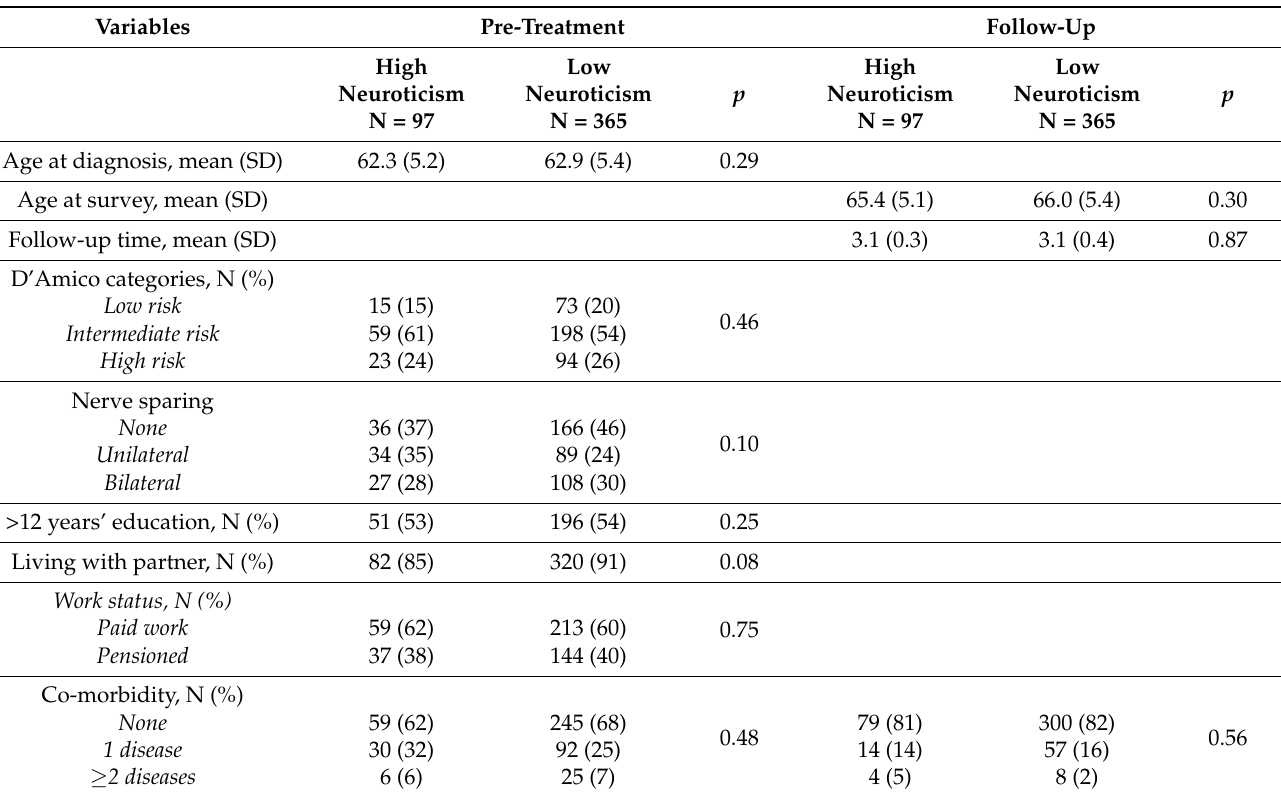
Table 1. Characteristics of the high and low neuroticism groups at pre-treatment and follow-up (N =